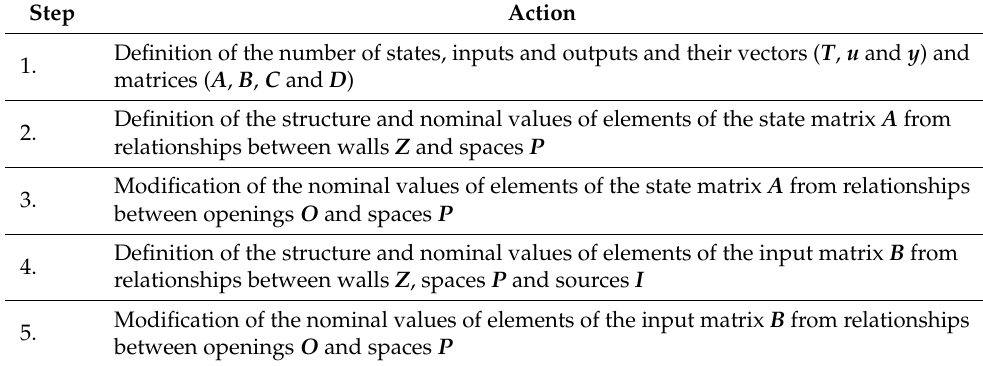
Table 1. Algorithm for defining the structure of a thermodynamic model of a